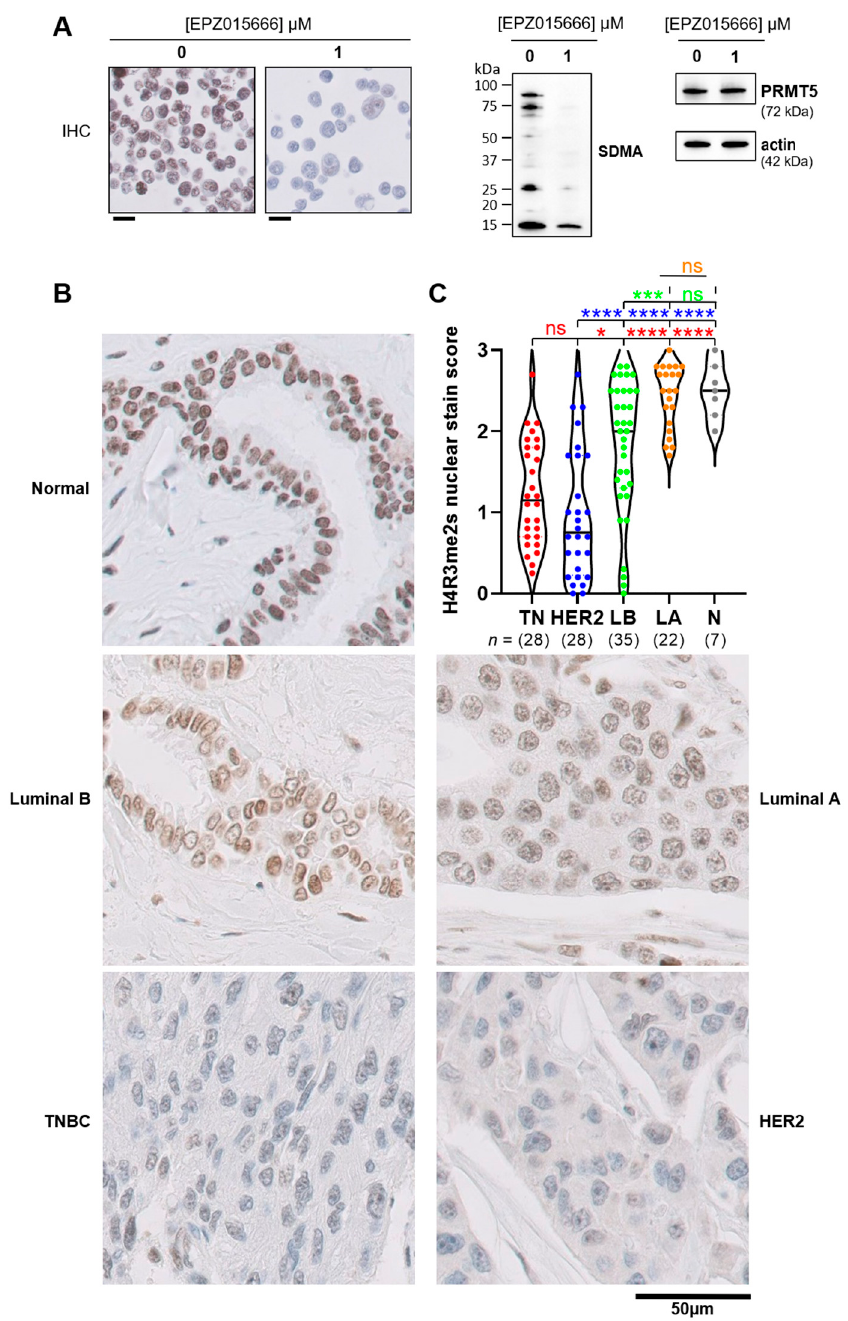
Figure 7. The hormone receptor-negative breast tumors express lower levels of symmetrically dimethylated histone H4 on Arginine 3 (H4R3me2s) compared to the other breast cancer subgroups and normal breast tissues. ( A ). Validation of an H4R3me2s antibody suitable for IHC staining. MDA- MB-453 cells were incubated with 1 µ M of a PRMT5 inhibitor (EPZ015666) or with DMSO as a control for 48 h. Cells were pelleted, fixed with AFA, paraffin-embedded and subjected to IHC staining with an anti-H4R3me2s antibody (scale bars = 20 µ m) (left panel). PRMT5 inhibition was verified by Western blotting using an anti-pan symmetric dimethyl-arginine (SDMA) antibody, and anti-PRMT5 and anti-actin antibodies were used as loading controls (right panel). The uncropped blots are shown in Figure S5. ( B ). Histone H4 is highly symmetrically dimethylated on arginine 3 in normal breast